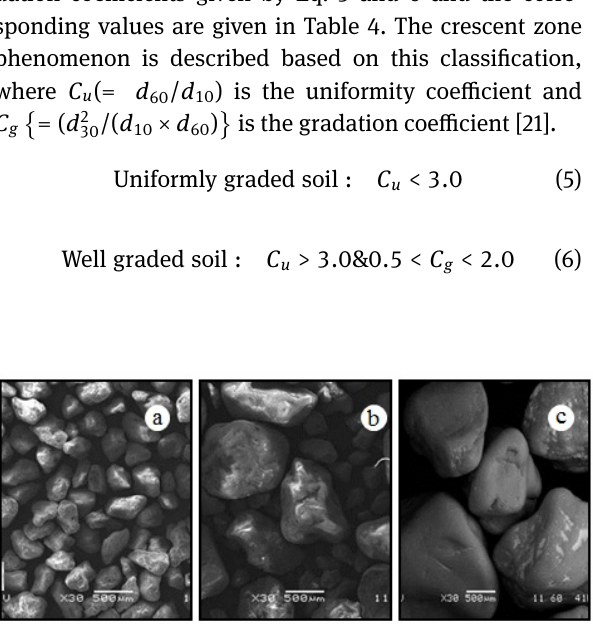
Figure 5: SEM images (a) Well graded soil sample of d 50 = 0.15 mm, (b) Poorly graded soil sample of d 50 = 0.26 mm, (c) Poorly graded soil sample of d 50 = 0.30 mm.